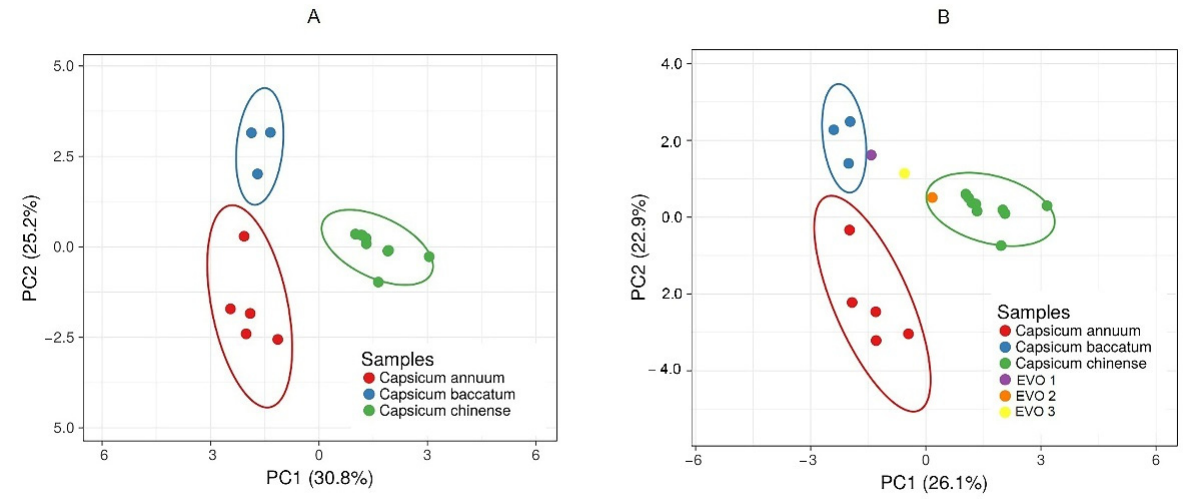
Figure 5. PCA analysis based on relative percentage areas of the 118 most abundant identified volatiles in chili peppers ( A ) and in chili peppers compared with chili-pepper-flavored extra virgin oils ( B ). X and Y axis show principal component 1 and principal component 2, which explain ( A ) 30.8% and 25.2% of the total variance and ( B ) 26.1% and 22.9% of the total variance, respectively. Prediction ellipses are such that with probability of 0.95, a new observation from the same group will fall inside the ellipse. N = 19 data points.